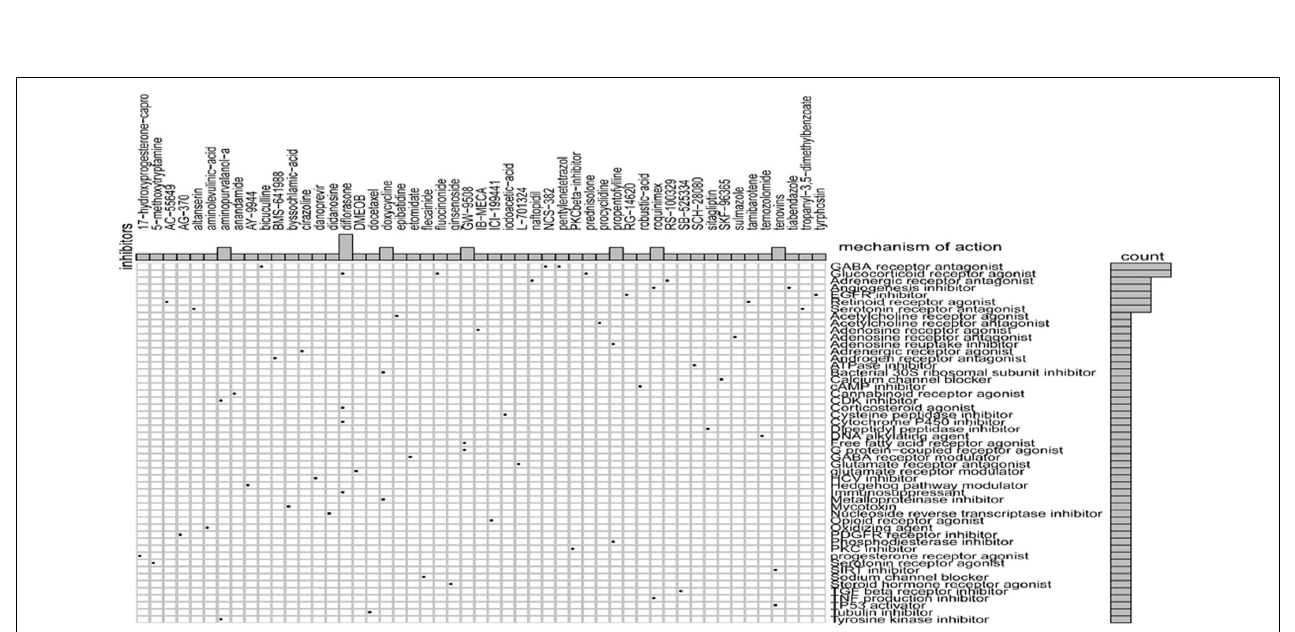
FIGURE 9 | CMap database analysis identifies novel candidate drugs targeting the glycolysis-related gene (GRG)-related signature.